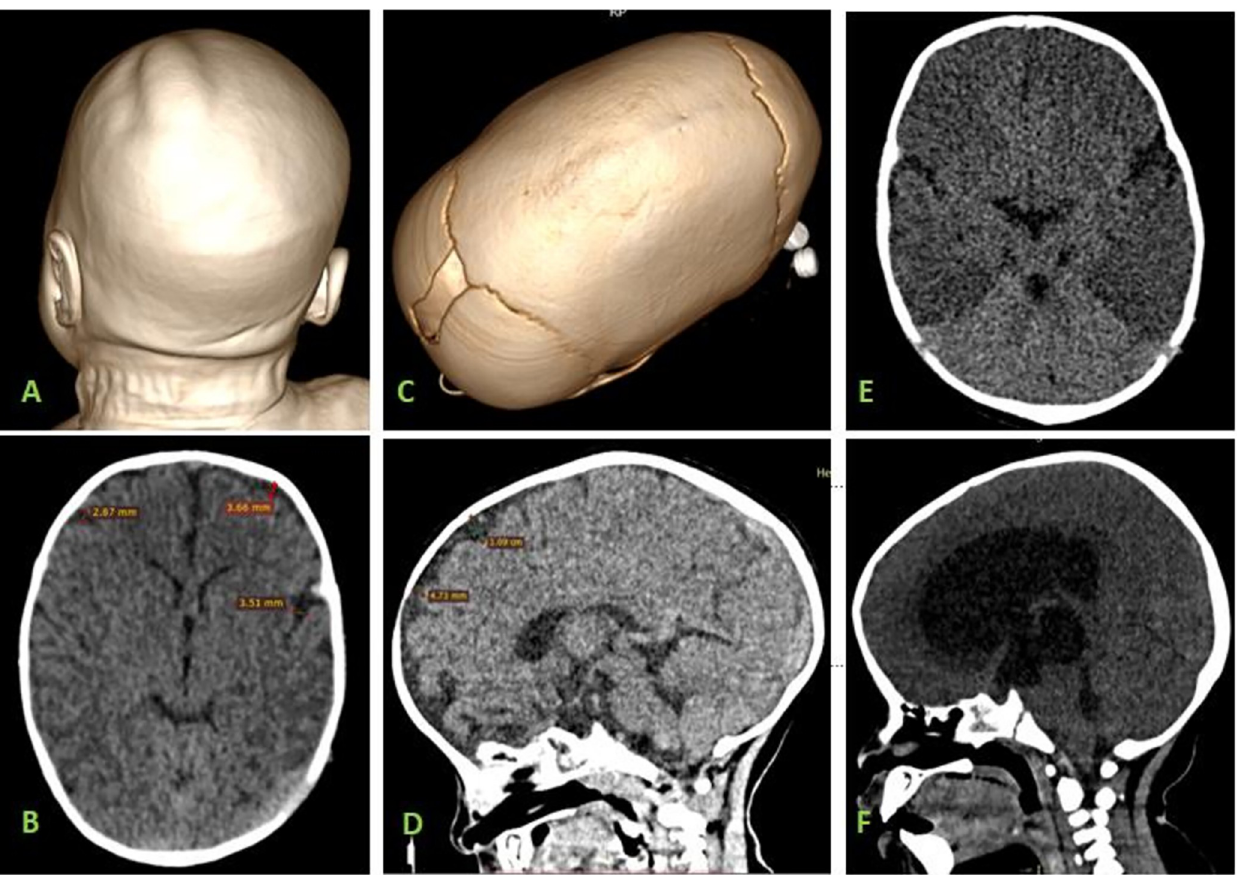
Fig 1. Selected head CT scans showing varying causes of brain volume loss. A: Volume rendering 3D CT scan image of a 3 months’ child with birth related head injury presenting with cephalohematoma at the vertex. B: Axial CT scan image of the same child A showing diffuse reduction in brain volume in cortical regions as evidenced by prominent sulci. C: Volume rendering 3D image of 1-year male child showing premature closure of the sagittal suture with overall increase in anterior-posterior diameter of the head(craniosynostosis). D: Sagittal CT brain image of the same child C showing loss of brain volume in the frontal lobes showing gross deviation from the calvarium with prominent CSF spaces. E: A 2 months’ female child presenting with diffuse reduction in cerebral hemispheric density sparing the cerebellum (White cerebella sign) representing hypoxic ischemic encephalopathy with early bi-temporal cerebral atrophy. F: A 4 months’ male child showing increased intracranial pressure evidenced by effacement of sulci and gyri as a result of ballooning of the lateral and 3 rd ventricles. The 4 th ventricle is small due to obstructive hydrocephalus following aquiductal